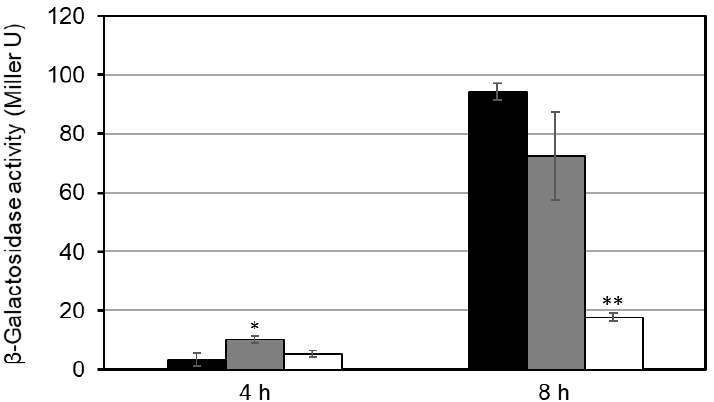
Figure 2. The promoter activity of lacZ fusions of a series of the ldhA promoter fragments. The ldhA promoter regions amplified with the primers F2/RV (black), F2-1/RV (gray), or F2-2/RV (white) were fused with lacZ and integrated into the wild-type chromosome. The resulting strains were grown in A medium supplemented with 1% glucose. β-Galactosidase activities of the cells at 4 h (i.e., exponential) and 8 h (i.e., stationary phase) were determined. Mean values obtained from three independent cultivations are shown with their standard deviations. p -values were calculated using an unpaired t -test. (*) p < 0.05; (**) p < 0.01 (comparison with F2/RV construct).